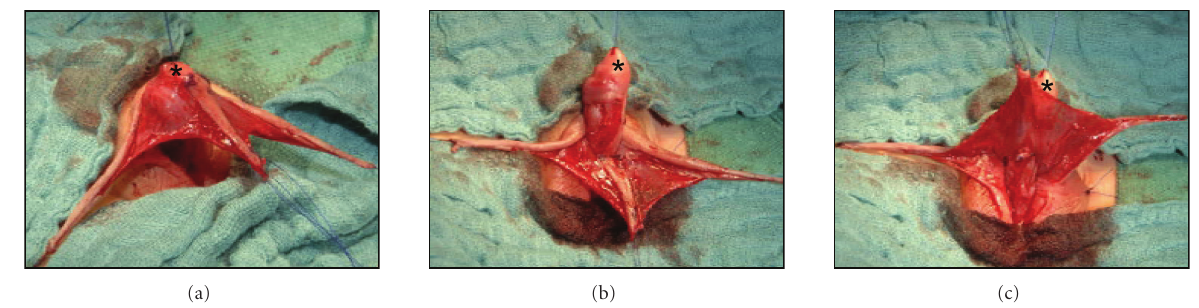
Figure 3: Ventral transposition of the longitudinal dorsal dartos flap with the buttonhole technique. Star shows the glans.